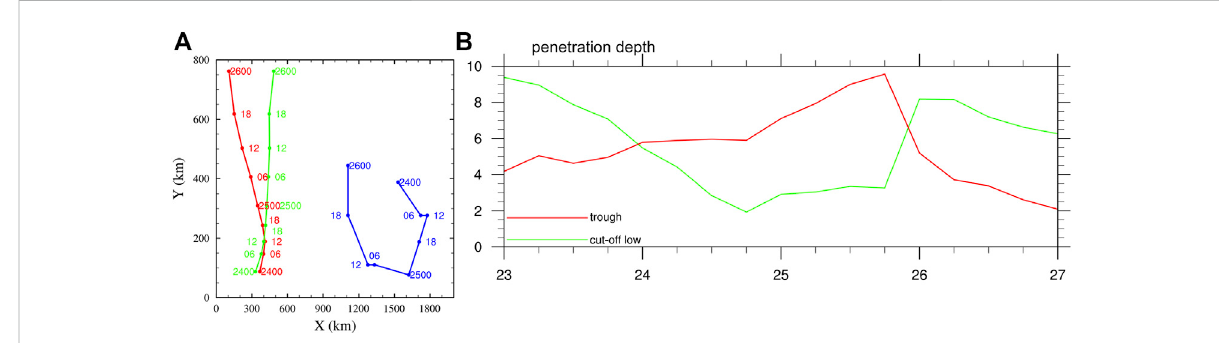
FIGURE 6 (A) Tracksof theTCand thecutoff low.The red (green)curverepresents thetrack inCTRL(No-trough),and thebluecurvedenotesthetrack of the cutoff low and (B) the time evolution of the lowest level at which the upper-level trough and cutoff low can penetrate (km).